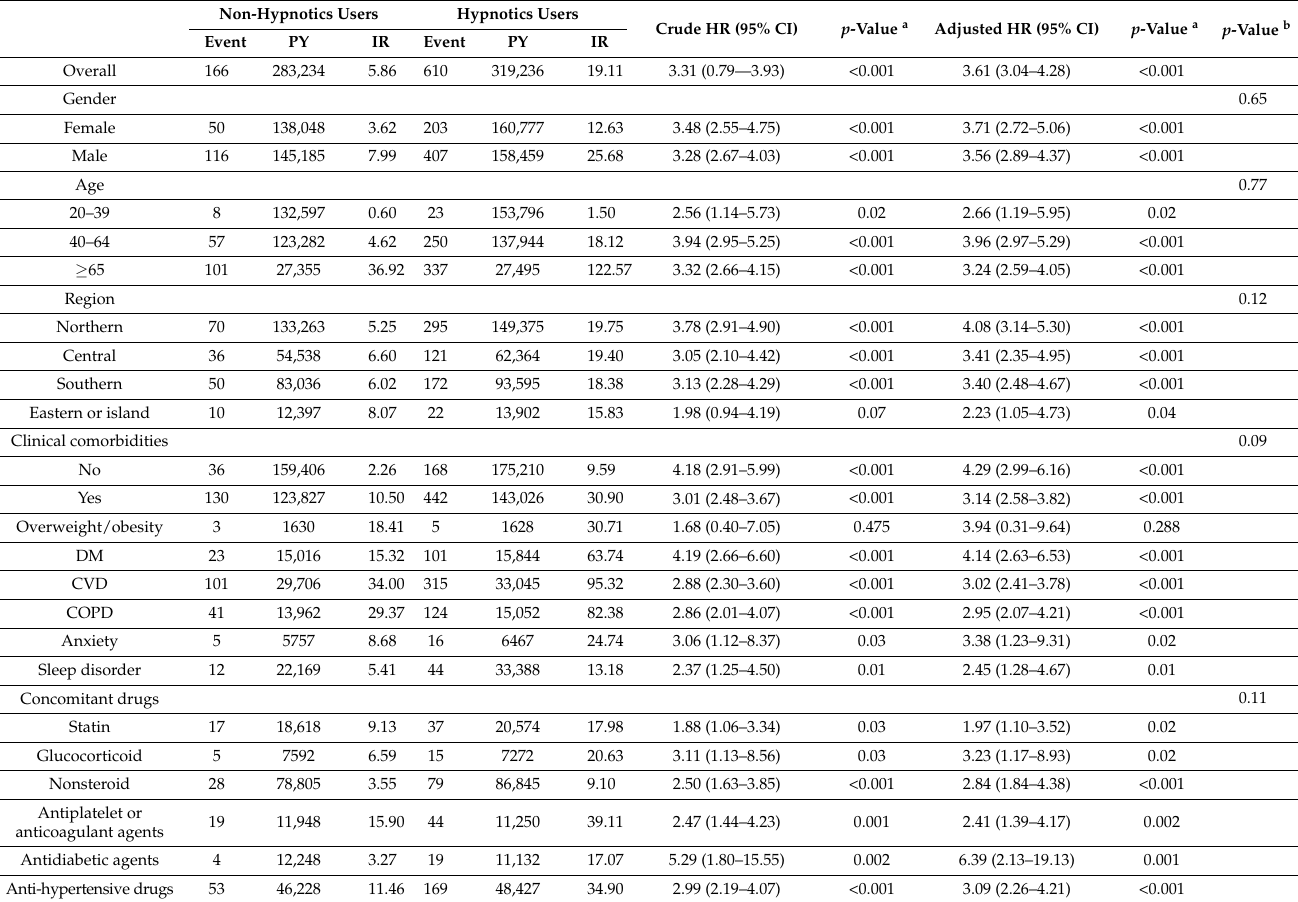
Table 2. Stratified analyses of the comparisons with non-hypnotics users for the incident atrial fibrillation in hypnotics